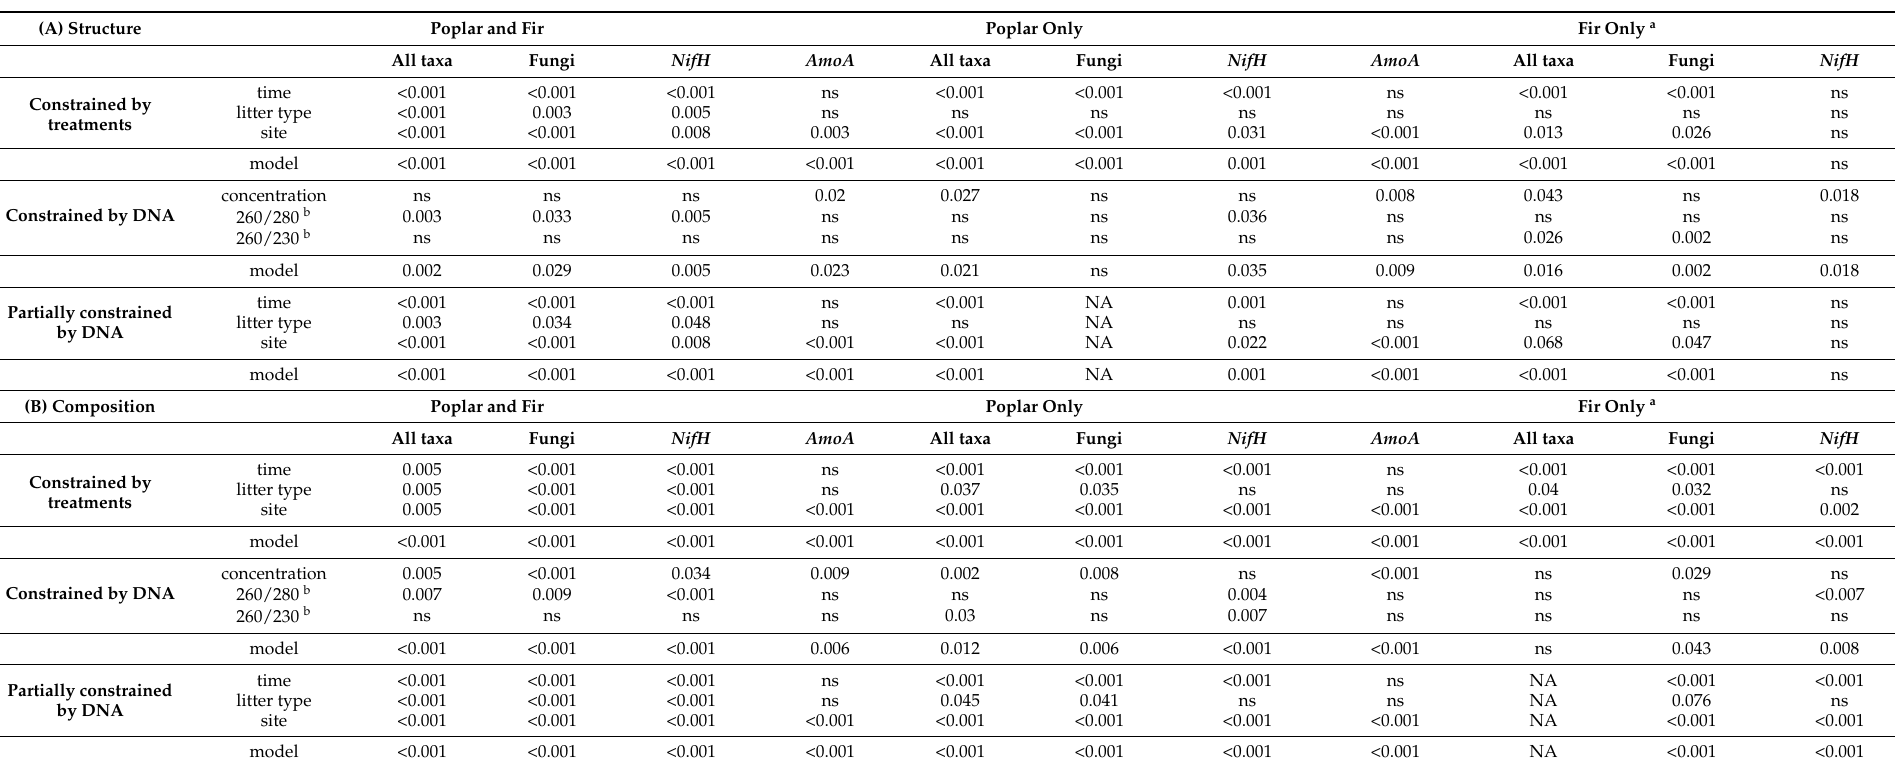
Table 3. Significance ( p -values) of categorical models and predictors in predicting microbial community structure ( A ; Shannon’s diversity, richness and Pielou’s evenness) or composition ( B ; presence/absence). Models constrained by categorical time, litter type and site predictors (constrained by treatment) or by the DNA concentration and λ absorbance (constrained by DNA) were reduced until only significant predictors remained ( α -level = 0.05), with non-significant variables labelled ‘ns’. Best fit categorical models were then assessed after removing the effects of DNA quality on microbial responses (partially constrained by DNA), with ‘NA’ labeling cases where DNA quality is not significant. Data from poplar and Douglas-fir litter were treated separately (poplar only and fir only, respectively) and jointly (poplar and fir). Fungi, AmoA and NifH functional groups were also treated separately and jointly (all